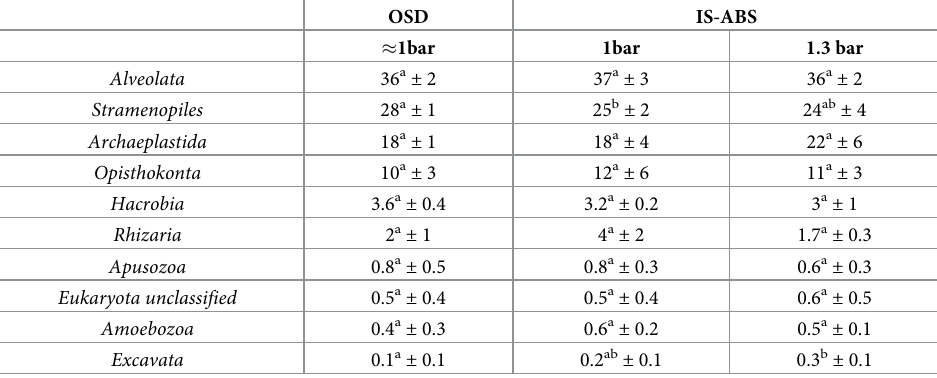
Table 4. Relative percentage of 18S OTUs Taxonomic composition at phylum level. Detected in the tests per- formed with the Ocean Sampling Day (OSD) standard procedure and with the autonomous Biosampler (IS-ABS) (mean ± standard deviation, n = 3). For IS-ABS two filtration pressures were selected (1 and 1.3 bars). Different super- script letters indicate significant (ANOVA, P < 0.05) differences among the three filtration procedures for each